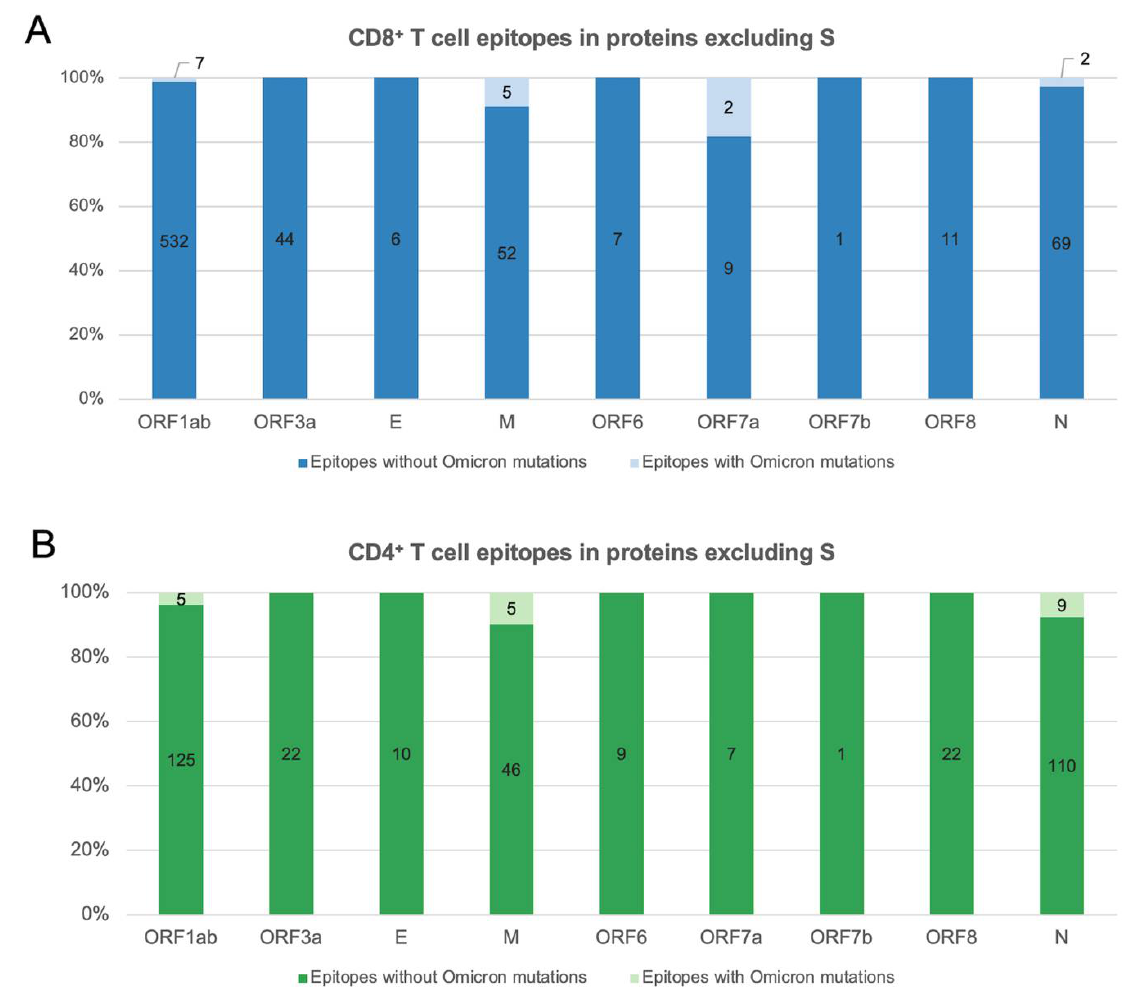
Figure 2. Percentage of SARS-CoV-2 T cell epitopes derived from proteins besides S with and without Omicron-defining mutations: ( A ) CD8 + T cell epitopes. ( B ) CD4 + T cell epitopes. Only epitopes of canonical lengths (CD8 + : 8–12 residues and CD4 + :15 residues) were included in the analysis. Omicron-defining mutations (that also include deletions) were obtained from https://covariants.org (accessed on 9 December 2021).